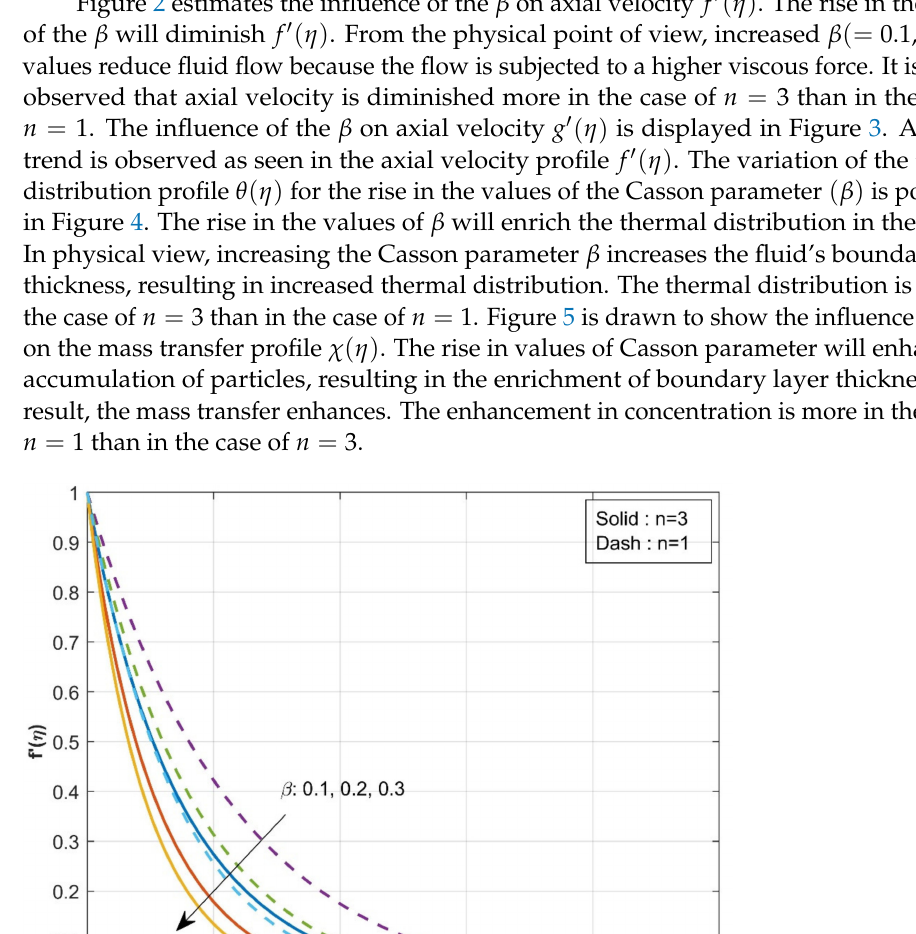
(cid:16) (cid:17) = 1. 1 + 1 β